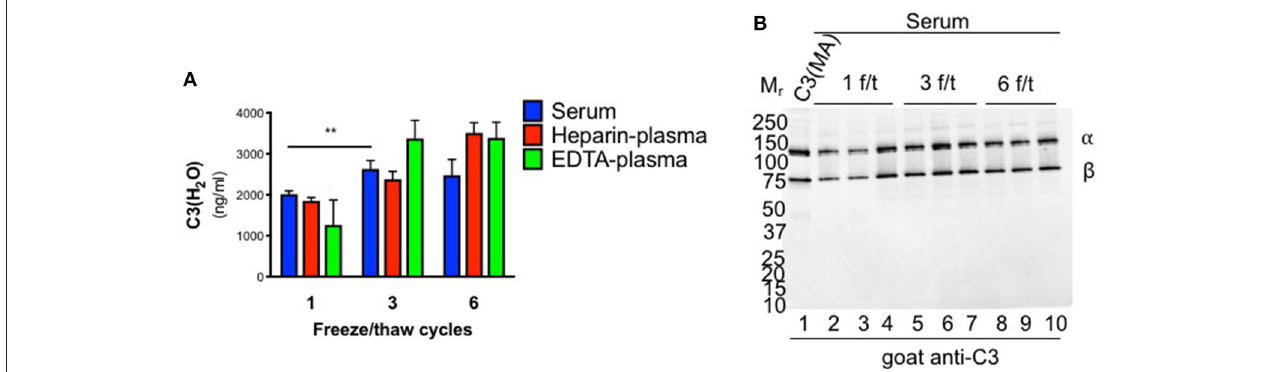
FIGURE 3 | Effect of freeze/thaw cycles on C3(H 2 O) generation. (A) Samples were subjected to 1, 3 or 6 freeze/thaw (f/t) cycles and the C3(H 2 O) content was measured; n = 3, ** p < 0.01. (B) C3 cleavage was assessed by WB in serum subjected to increasing f/t cycles. No evidence of C3(H 2 O) degradation is observed. Notably, the sensitivity of the WB is ∼ 10 ng and even an over-exposure fails to show additional